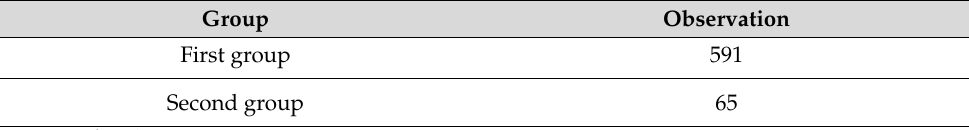
Table 2. Clustering rice production in the Upper North of Thailand by the K-Means